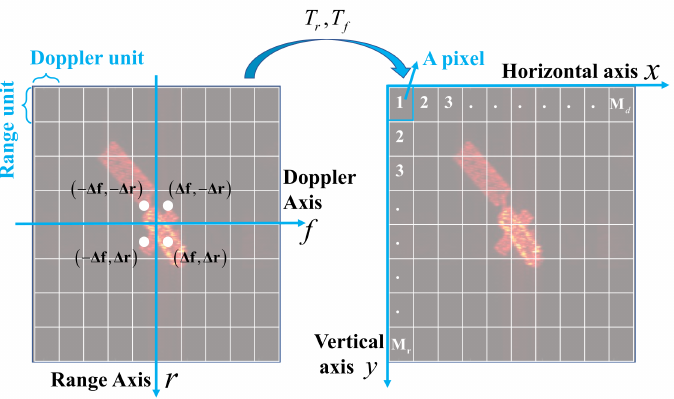
Figure 4. The range-Doppler coordinate system and the image coordinate system in an ISAR